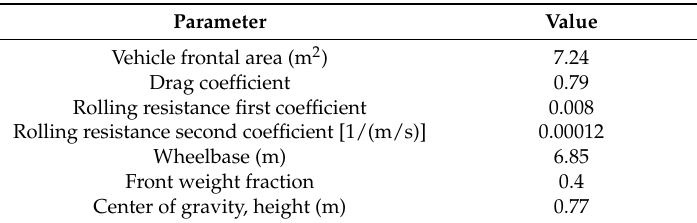
Table 6. Simulation model common parameters.